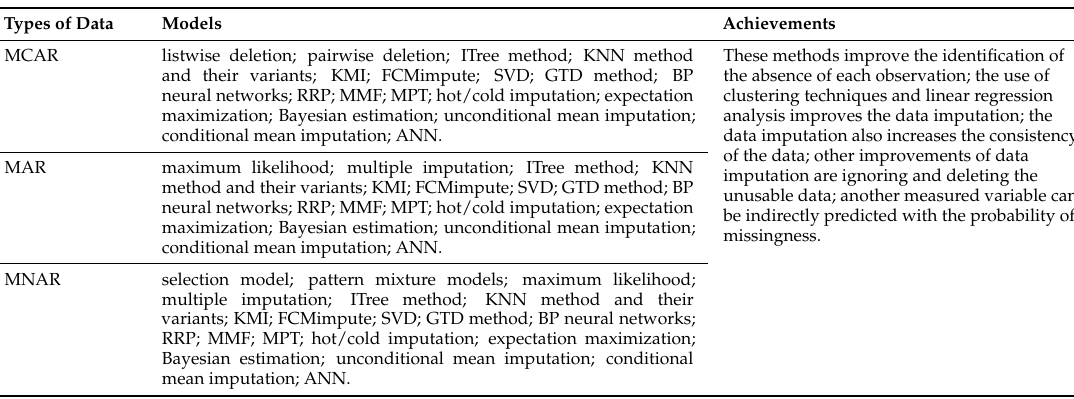
Table 4. Examples of data imputation